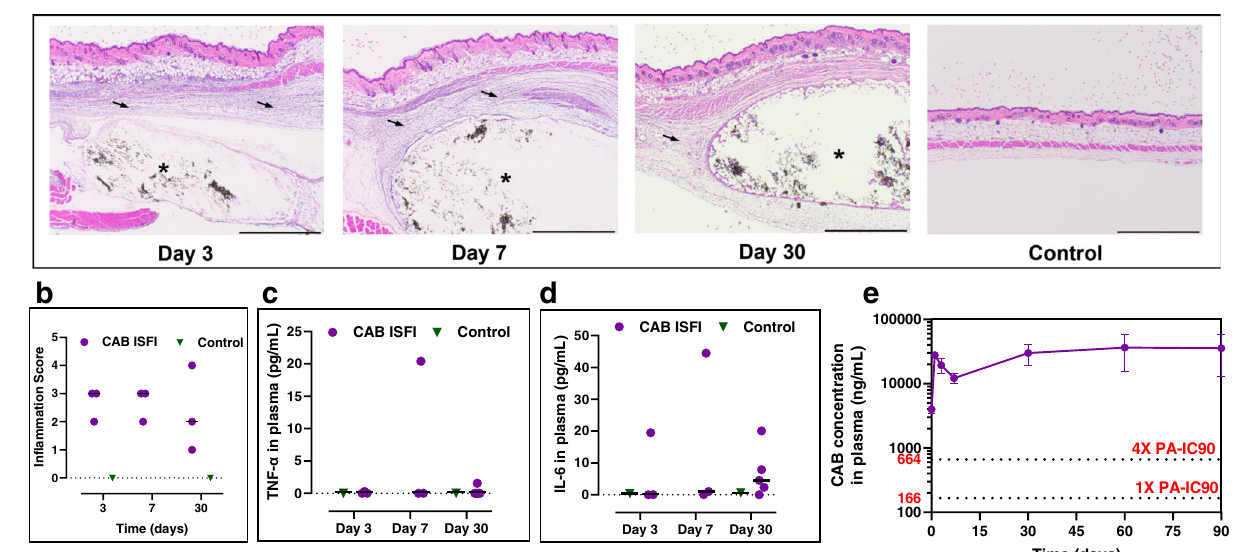
Fig.3|InvivosafetyevaluationandinvivodrugreleaseofCABISFIsinBALB/c mice. a Local in fl ammation of excised depots and surrounding subcutaneous tis- sues collected at day 3, 7, and 30 post-injection ( n =3/timepoint for CAB ISFI treated mice and n =1/timepoint for control (no injection) mice) and stained with H&E. Asterisks indicate CAB implant. Arrows indicate in fi ltrated immune cells and areas of in fl ammation. All scale bars represent 1mm. b In fl ammatory score of subcutaneoustissuesurroundingthedepotevaluatedusingalightmicroscopeand scored blindly by a certi fi ed pathologist. Black bars represent the median in fl